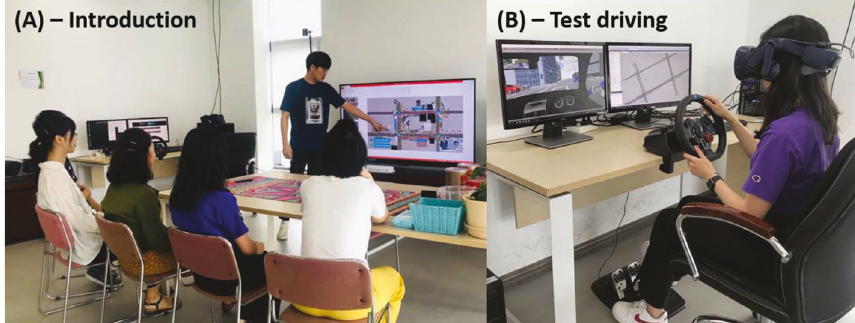
Figure 4: Training and test-driving session. (a) Introduction. (b) Test